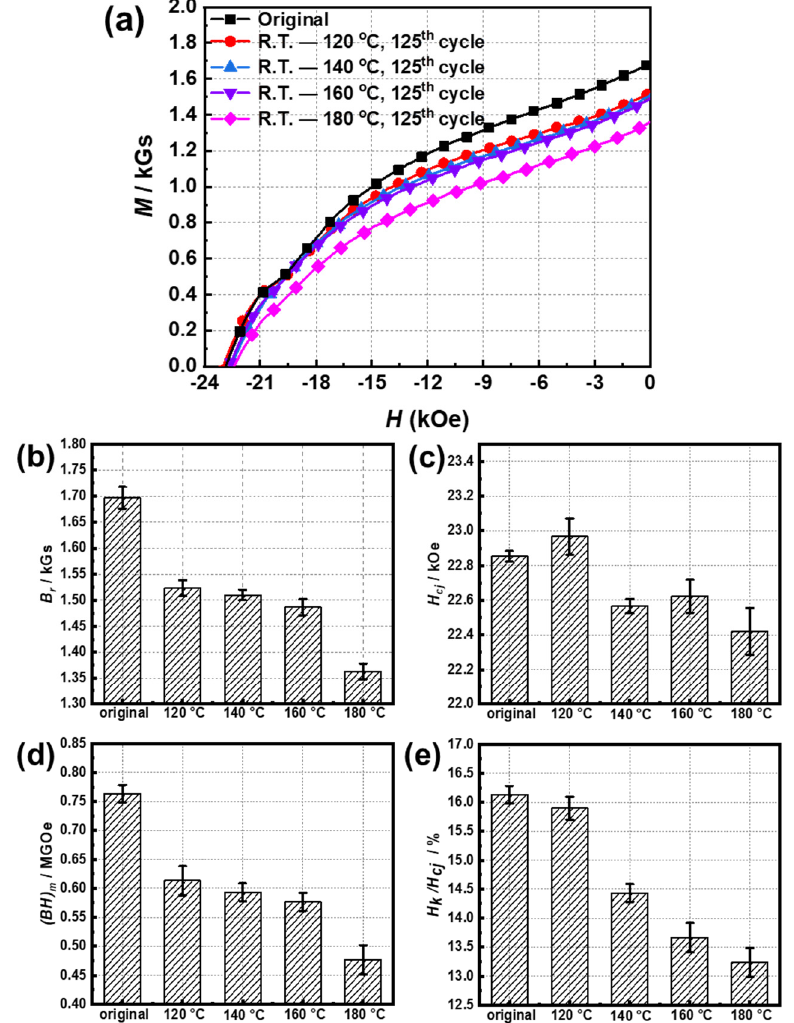
Figure 3. ( a ) Demagnetization curves, ( b ) B r , ( c ) H cj , ( d ) ( BH ) max , and ( e ) H k / H cj of the samples after the 125th cycle at different upper limit temperatures.